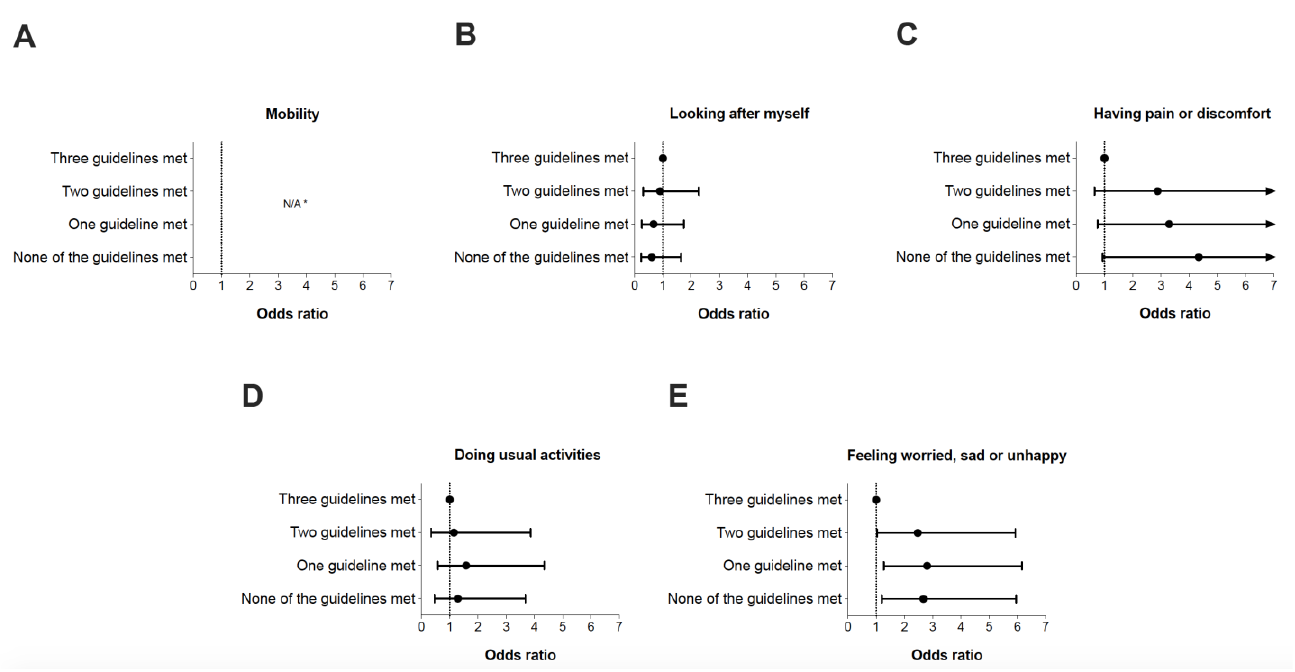
Figure 3. Association between meeting 24 h movement guidelines and problems in different dimen- sions of HRQoL (Odds Ratio and Confidence Intervals). ( A ) Mobility; ( B ) Looking after myself; ( C ) Having pain or discomfort; ( D ) Doing usual activities; ( E ) Feeling worried, sad or unhappy. Adjusted for age, sex, nationality, breadwinner’s educational level, socioeconomic status, body mass index (z-score), and Mediterranean Diet. * Note: The mobility dimension did not present a high enough number of cases with problems; therefore, the analysis was not applicable